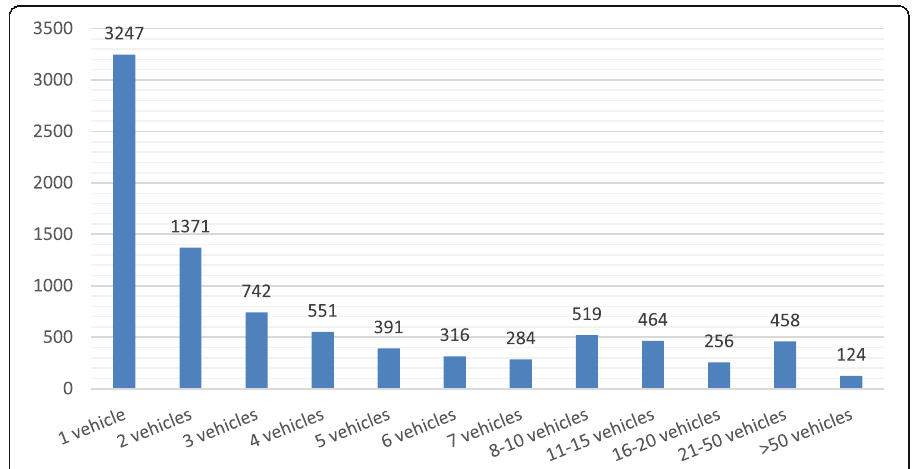
Fig. 1 Overview of Belgian trucking companies ’ fleet size [source: FOD Mobiliteit